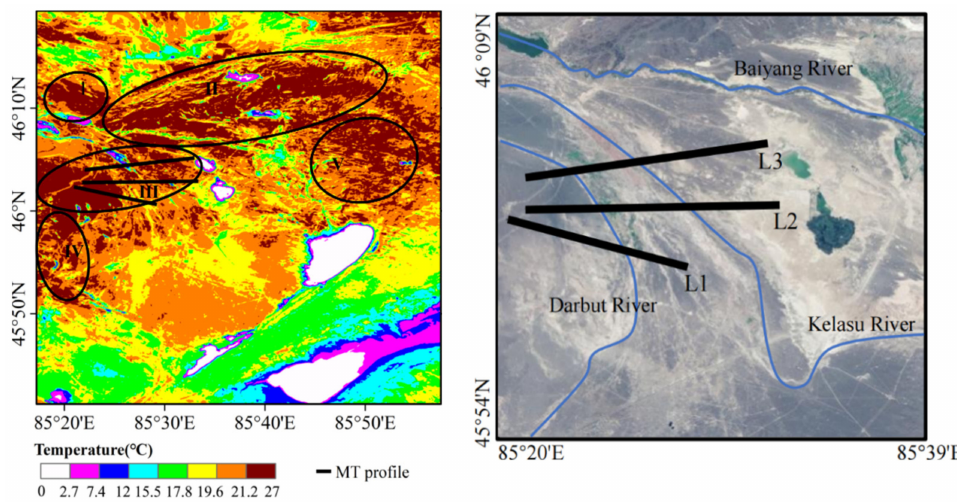
Figure 5. ( left ) LST retrieval results in the study area; ( right ) MT profile